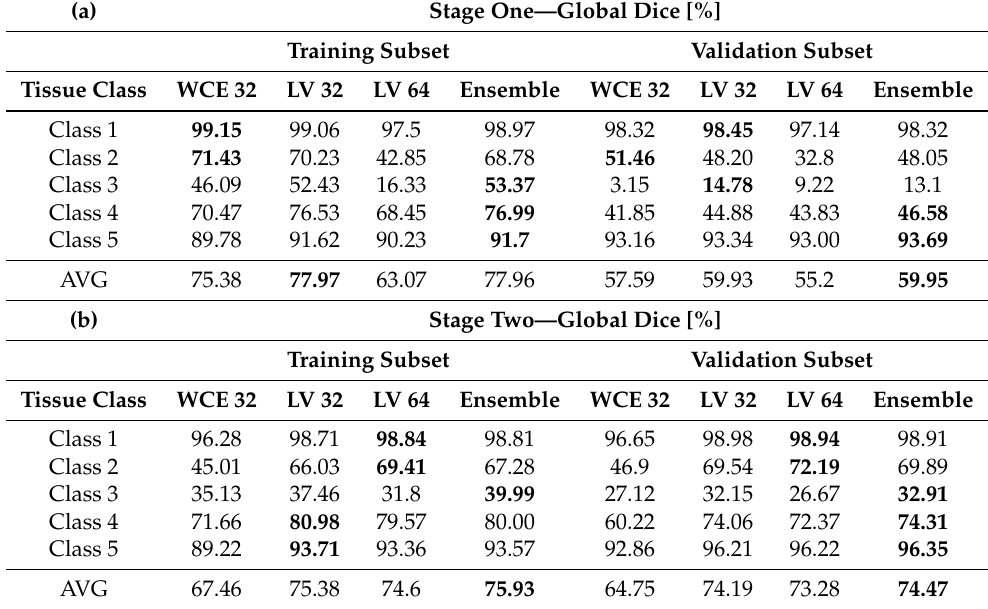
Table 2. ( a ) Global Dice (in %) of the networks evaluated on validation subset of the stage one manual draft segmentations. ( b ) Global Dice (in %) of the stage two networks evaluated on training and validation datasets. In bold the best results are shown for a class in an individual subset of data. (weighted cross entropy loss—WCE, Lovasz loss—LV, 32 filters at first layer—32, 64 filters at first layer—64).